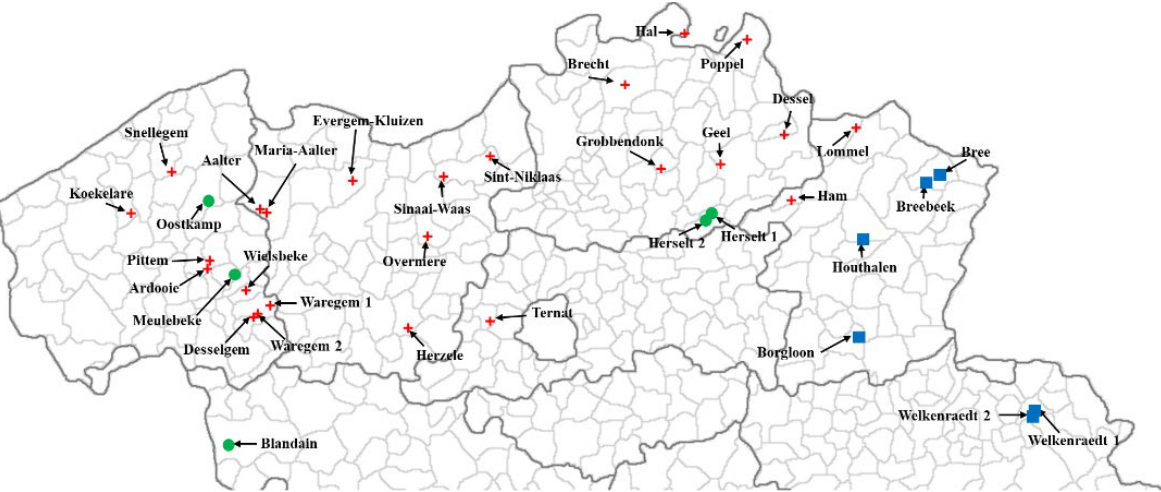
Figure 1. Sampling locations of the 35 C. esculentus clonal populations used in the genetic and morphological clustering experiments. Locations are marked with a symbol and colour according to their genetic cluster (red for cluster A, green for cluster B, and blue for cluster C; see Figure 3). See Table 1 f or GPS - coordinates and pedohydrological conditions.